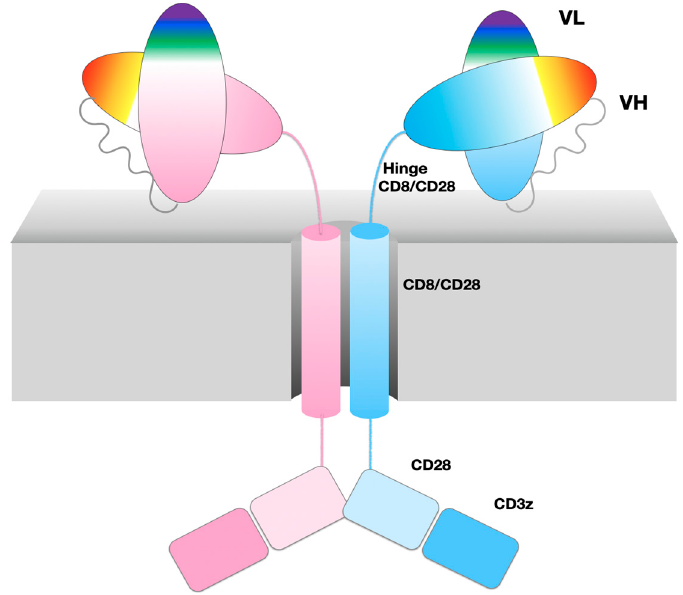
Figure 1. 47G4-CD828Z CAR domains and the VL-VL dimer. Cartoon of CAR domains, represented as an ideal dimer. A single chain is composed of two immunoglobulin domains VL and VH from the 47G4 antibody, chained together in that order as an scFv followed by the CD8a hinge and transmembrane regions, and costimulatory domains extracted from CD28 and CD3zeta. The CAR name describes its composition in abbreviated form 47G4-CD828Z.